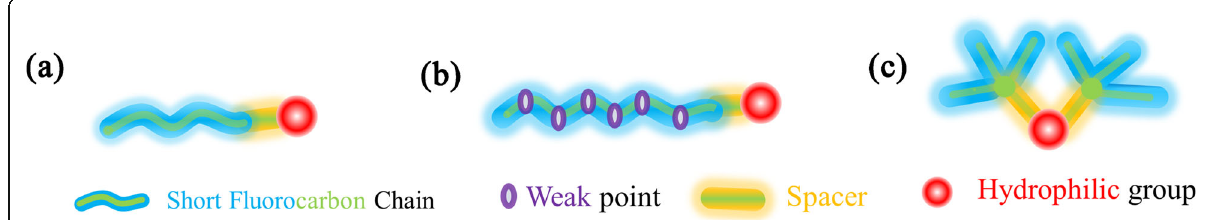
Fig. 1 Simplified schematic illustration of non-bioaccumulable fluorinated surfactants with different fluorocarbon chain structures: a the short perfluorocarbon chain; b the fluorocarbon chain with weak points; c the branched fluorocarbon